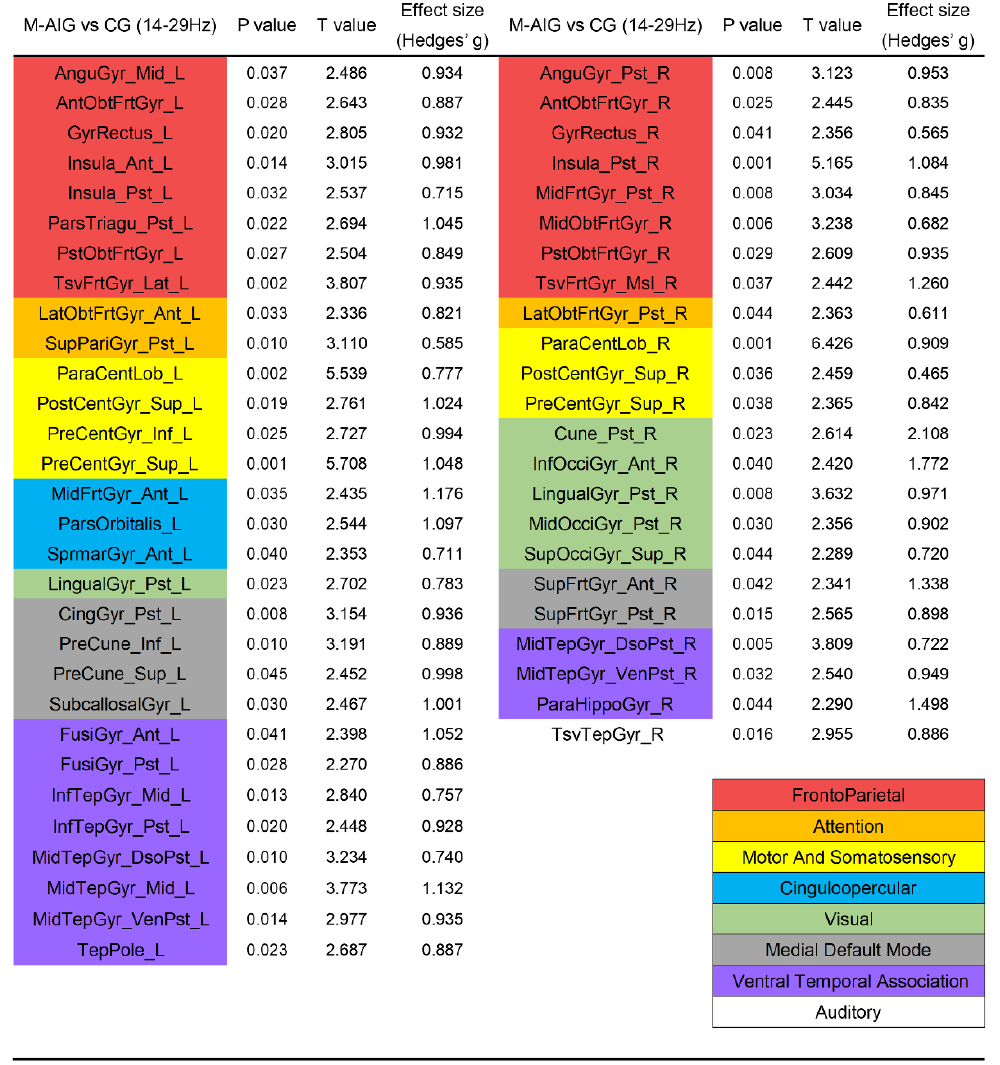
Figure 4. Comparison of ROIs’ activation between M-AIG and CG in beta band. M-AIG: male action observation-induced group; CG: control group; L: left, R: right; p < 0.05, FDR corrected (for the full name of ROIs see Supplementary Table S1). Colors for functional modules: red: frontoparietal system; orange: attention system; yellow: motor and somatosensory system; blue: cinguloopercular system; green: visual system; grey: medial default mode system; purple: ventral temporal association system; white: auditory system.